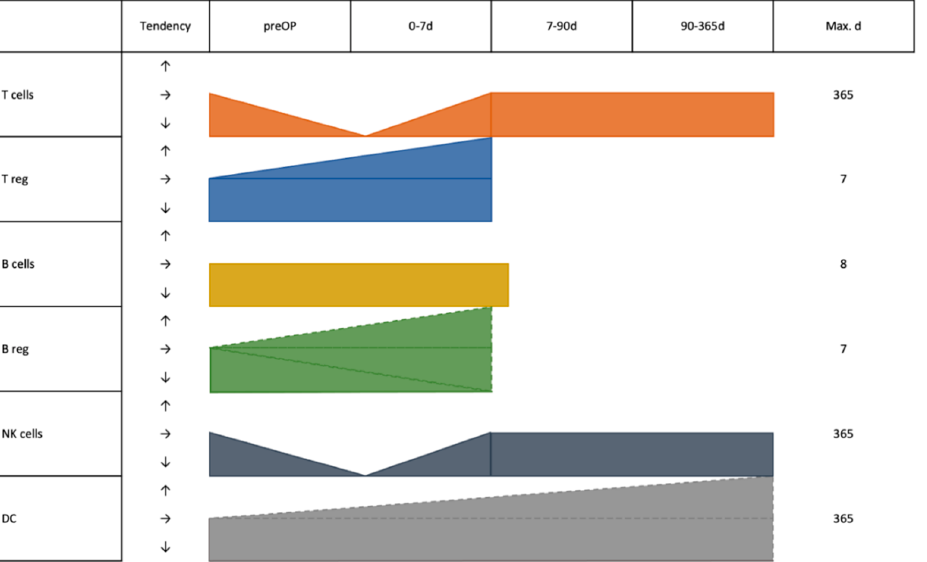
Figure 3. Graphical depiction of the dynamics of major immune cells after resection of gastrointestinal tumors. Dashed lines indicate contradictory results from different studies.